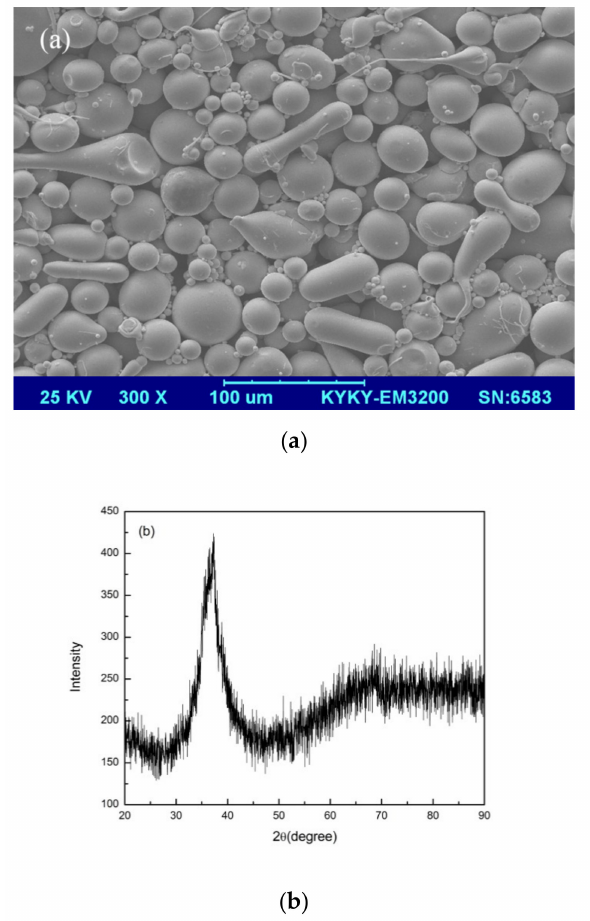
Figure 1. ( a ) SEM image and ( b ) XRD pattern of the Zr 60 Fe 10 Cu 20 Al 10 metallic glass